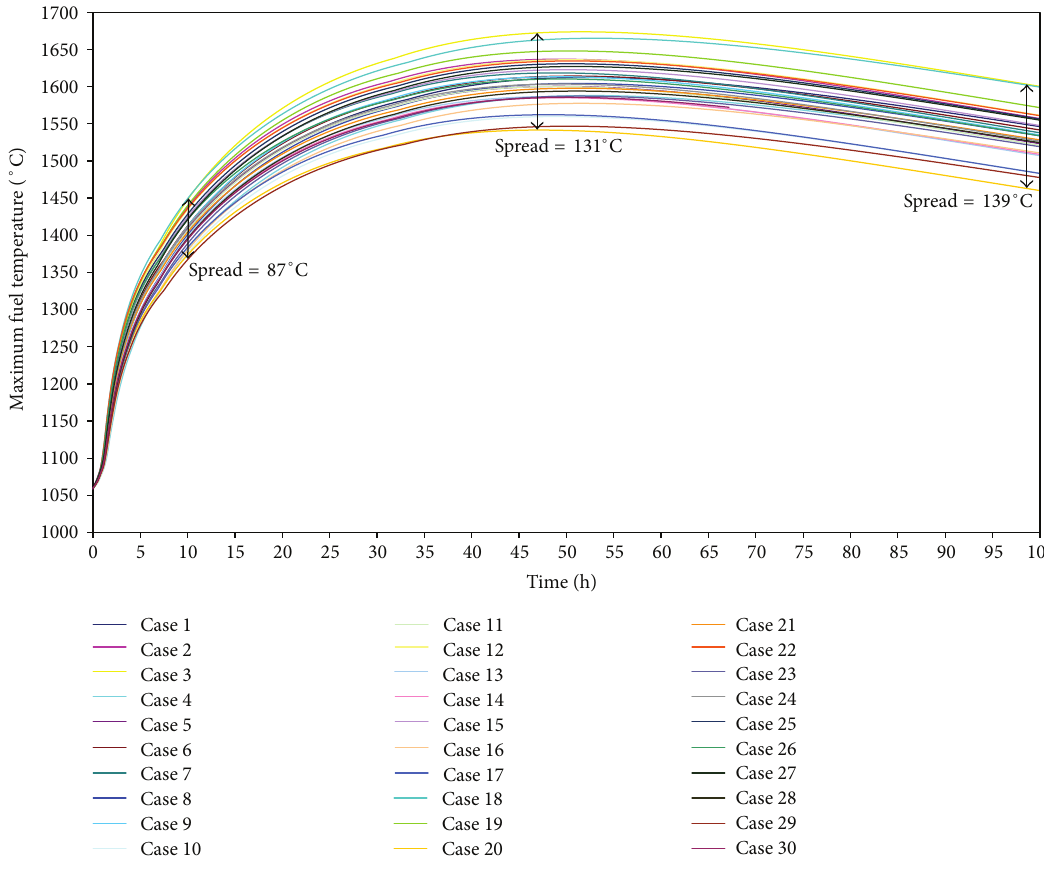
F 5: DLOFC maximum fuel temperature versus time for the �rst 30 cases of the 100 LHS Normal